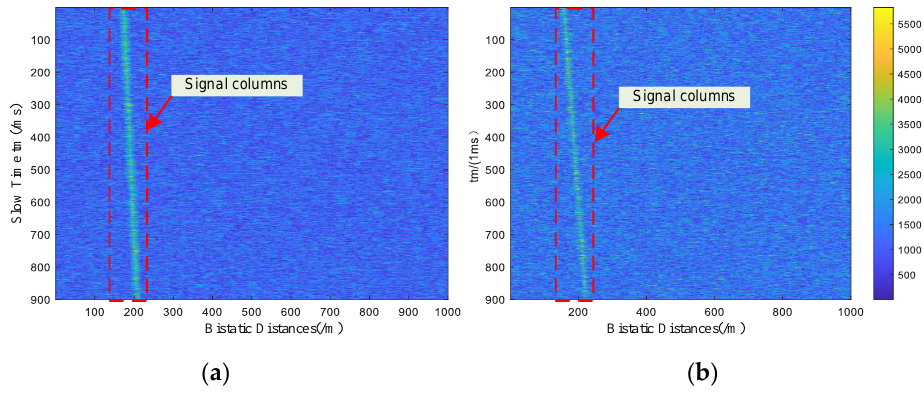
Figure 9. Target echo signal diagram of satellite 1 ( a ) and satellite 2 ( b ).